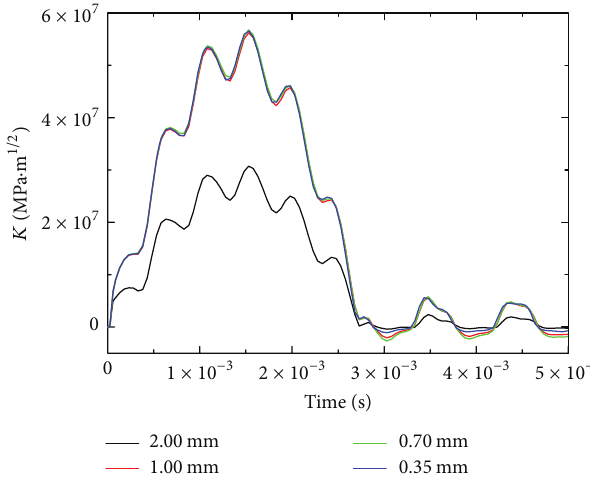
Figure 3: The mode I DSIFs of different mesh sizes at node 1 with fixed crack length of 0.02 m and impact speed of 5